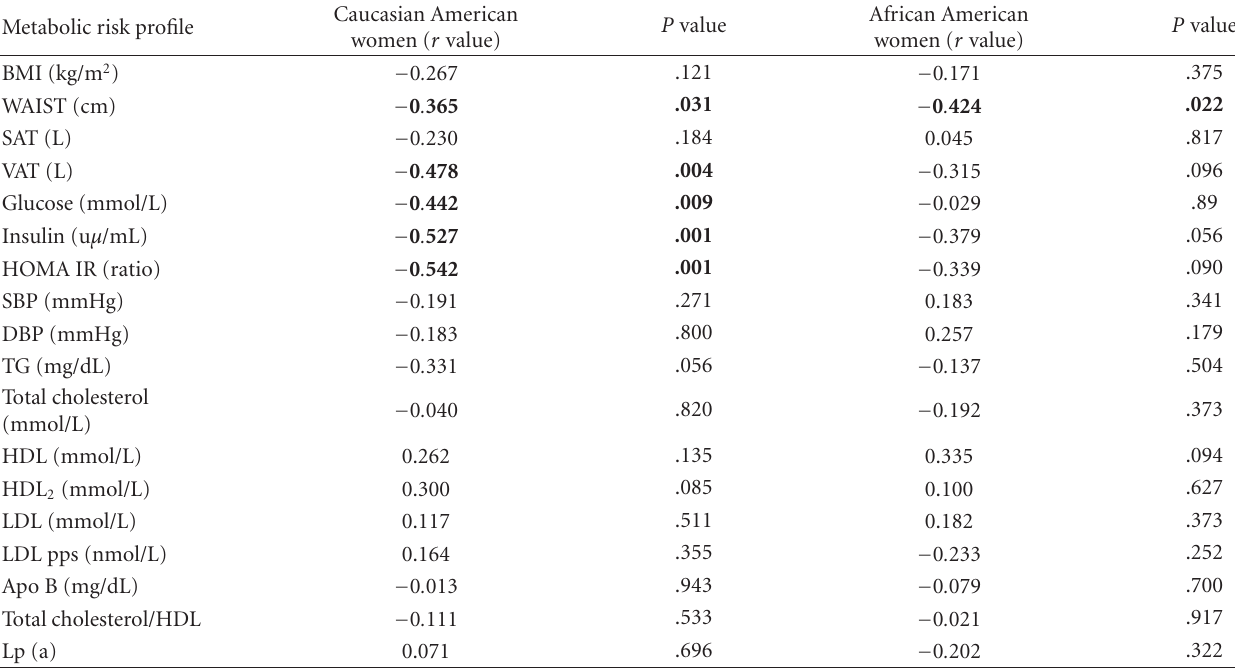
Table 4: Pearson correlation coe ffi cients between sex hormone binding globulin (log transformed) and the metabolic risk profile after adjusting for